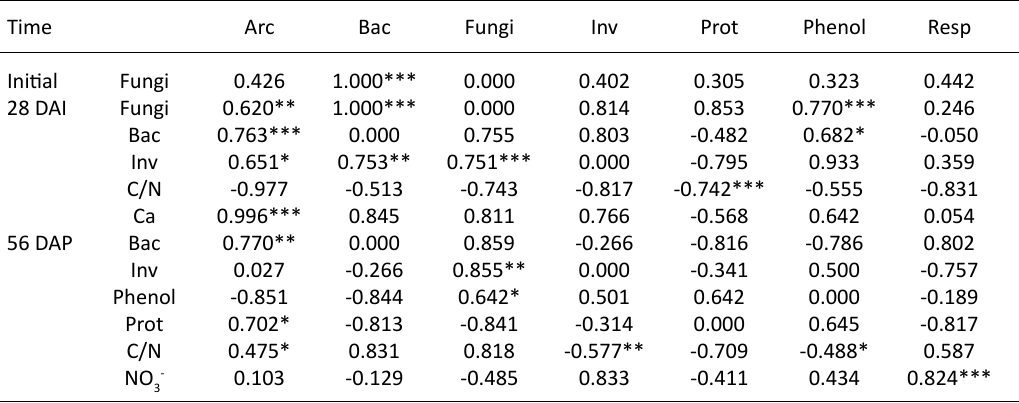
Table 4. Pearson's correlation coefficients (r) among biological properties and soil chemical properties evaluated at initial stage of the experiment, 28 days after incorporation (DAI) and 56 days after planting (DAP) Time